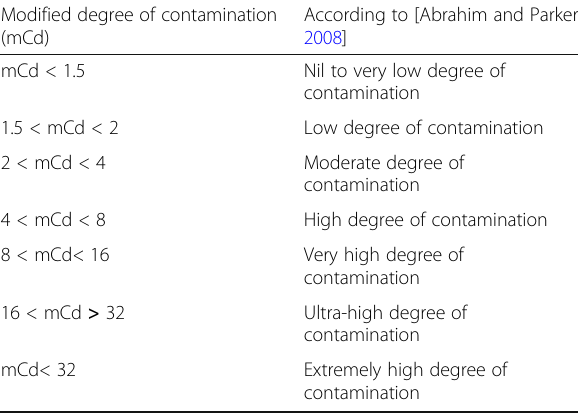
Table 1 Modified degree of contamination